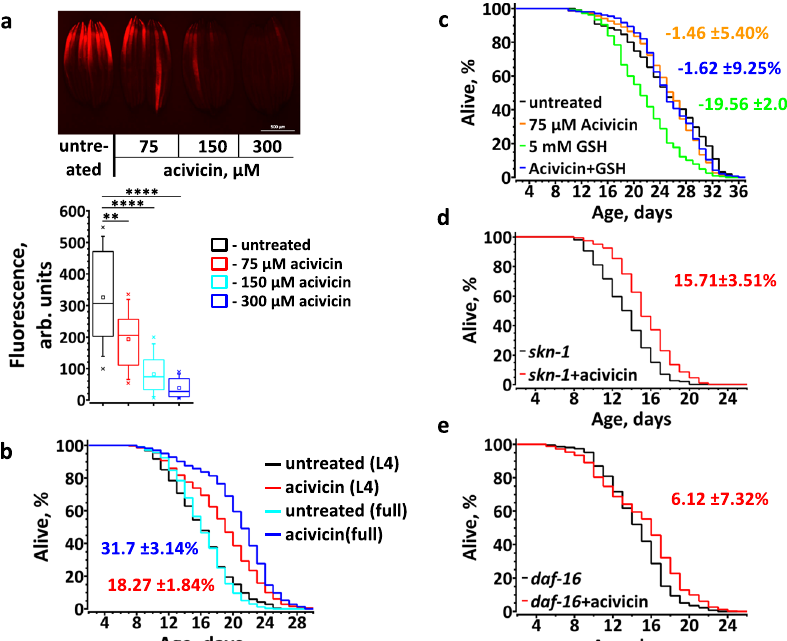
Fig. 5 Restriction of exogenous GSH increases C. elegans lifespan. a Representative fl uorescent image (top) and quanti fi cation (bottom) demonstrating total thiols level in live animals exposed to the escalating concentrations of acivicin. L4 stage wt worms were reared on plates supplemented with various concentration of acivicin. At day 3 of adulthood worms were stained with ThioFluor 623. Box plot indicate median (middle line), 25th, 75th percentile (box) and 5th and 95th percentile (whiskers) as well as maximum, minimum and mean (single points). n = 68 – 126 worms over three independent experiments. See also Supplementary Table 7. On the graph p values are: ** p < 0.01; **** p < 0.0001; two-tailed t -tests. b The ɣ GT inhibitor, acivicin, signi fi cantly extends the lifespan of C. elegans . Worms were exposed to acivicin either from stage L4 (L4, red trace) or from eggs (full, blue trace). n = 256(untreated from L4), 264(acivicin from L4), 198(untreated from eggs), 309(acivicin from eggs). c Acivicin extends C. elegans lifespan by inhibiting GSH uptake by C. elegans . L4 stage worms were transferred to plates with killed bacteria and supplemented with acivicin, GSH, or both ( n = 154(untreated), 193(acivicin), 191(GSH), 240(acivicin + GSH). d Acivicin extends the lifespan of skn-1 (zu67) worms ( n = 123(untreated), 146(acivicin)). e Acivicin fails to substantially extend the lifespan of daf-16 worms. Average percentage change ±SD of the lifespan relative to untreated control is indicated in matching color ( n = 324(untreated),